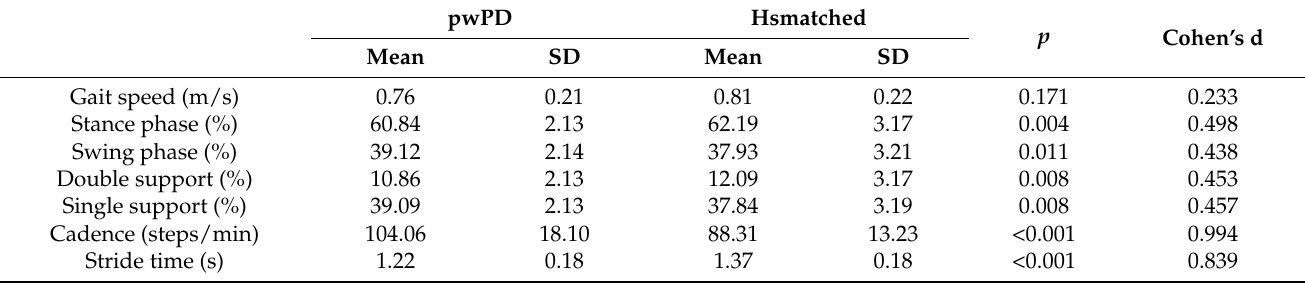
Table 1. Features selection: independent sample t -test. We performed an independent sample t -test to analyze which features showed significant differences, regardless of gait speed: pwPD, persons with Parkinson’s disease; HR, harmonic ratio; RQArec, %recurrency in the recurrence quantification analysis; RQAdet, % determinism in the recurrence quantification analysis; CV, coefficient of variation of the step